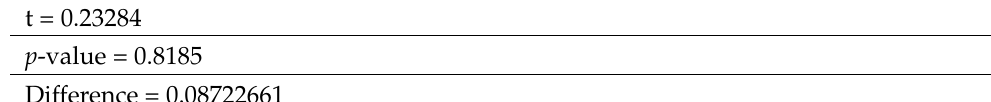
Table 3. Results of paired t -test applied to data of Experiment 1 after correction.